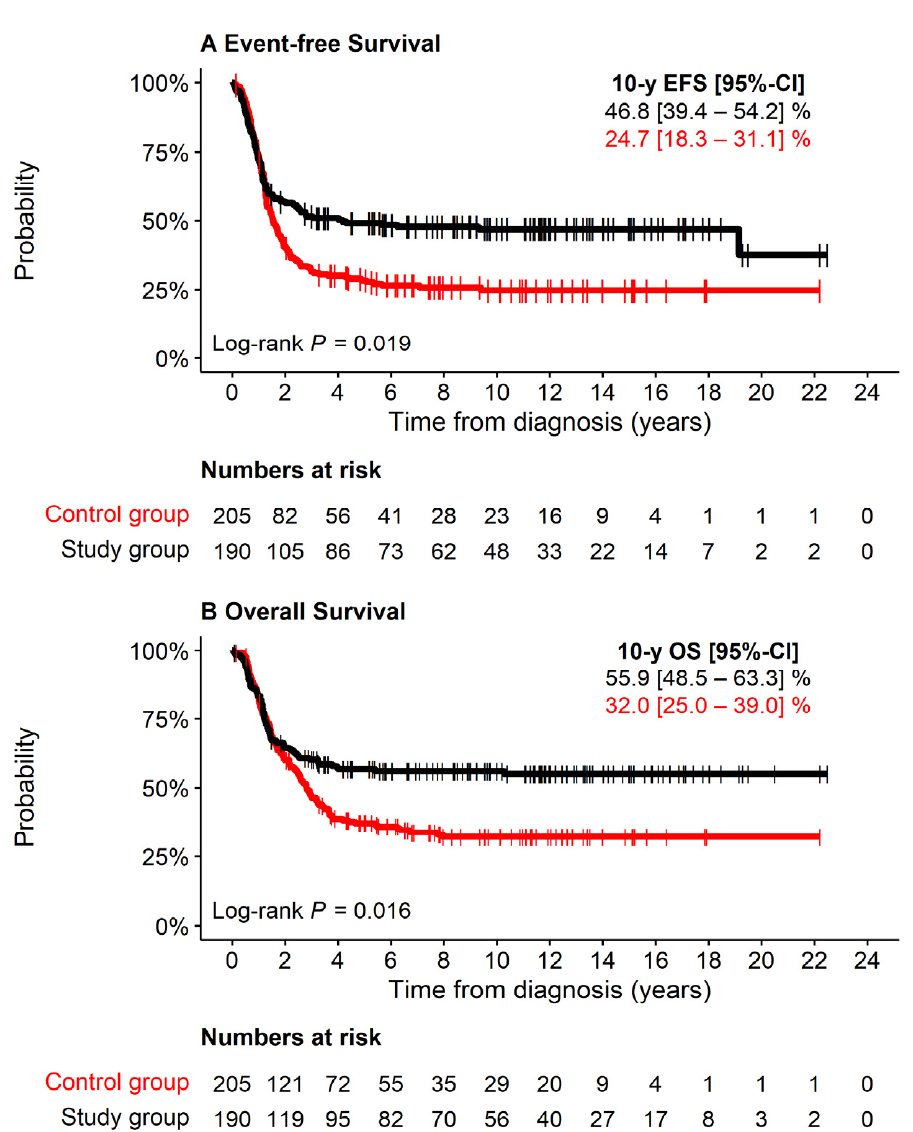
Figure 2. EFS and OS of 190 study patients attributed to high-risk solely due to MNA (black), 205 patients with stage 4 aged >18 months at diagnosis and MNA (control group, red). (A) Event-free Survival. (B) Overall Survival. Survival. ( B ) Overall